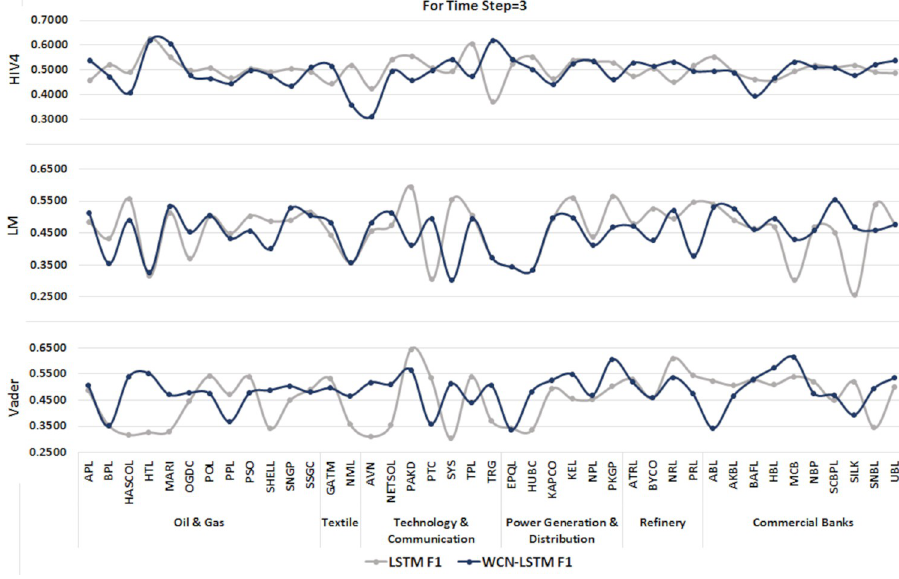
Fig 5. F1-score of prediction models by incorporating information from the last 3 days using the test